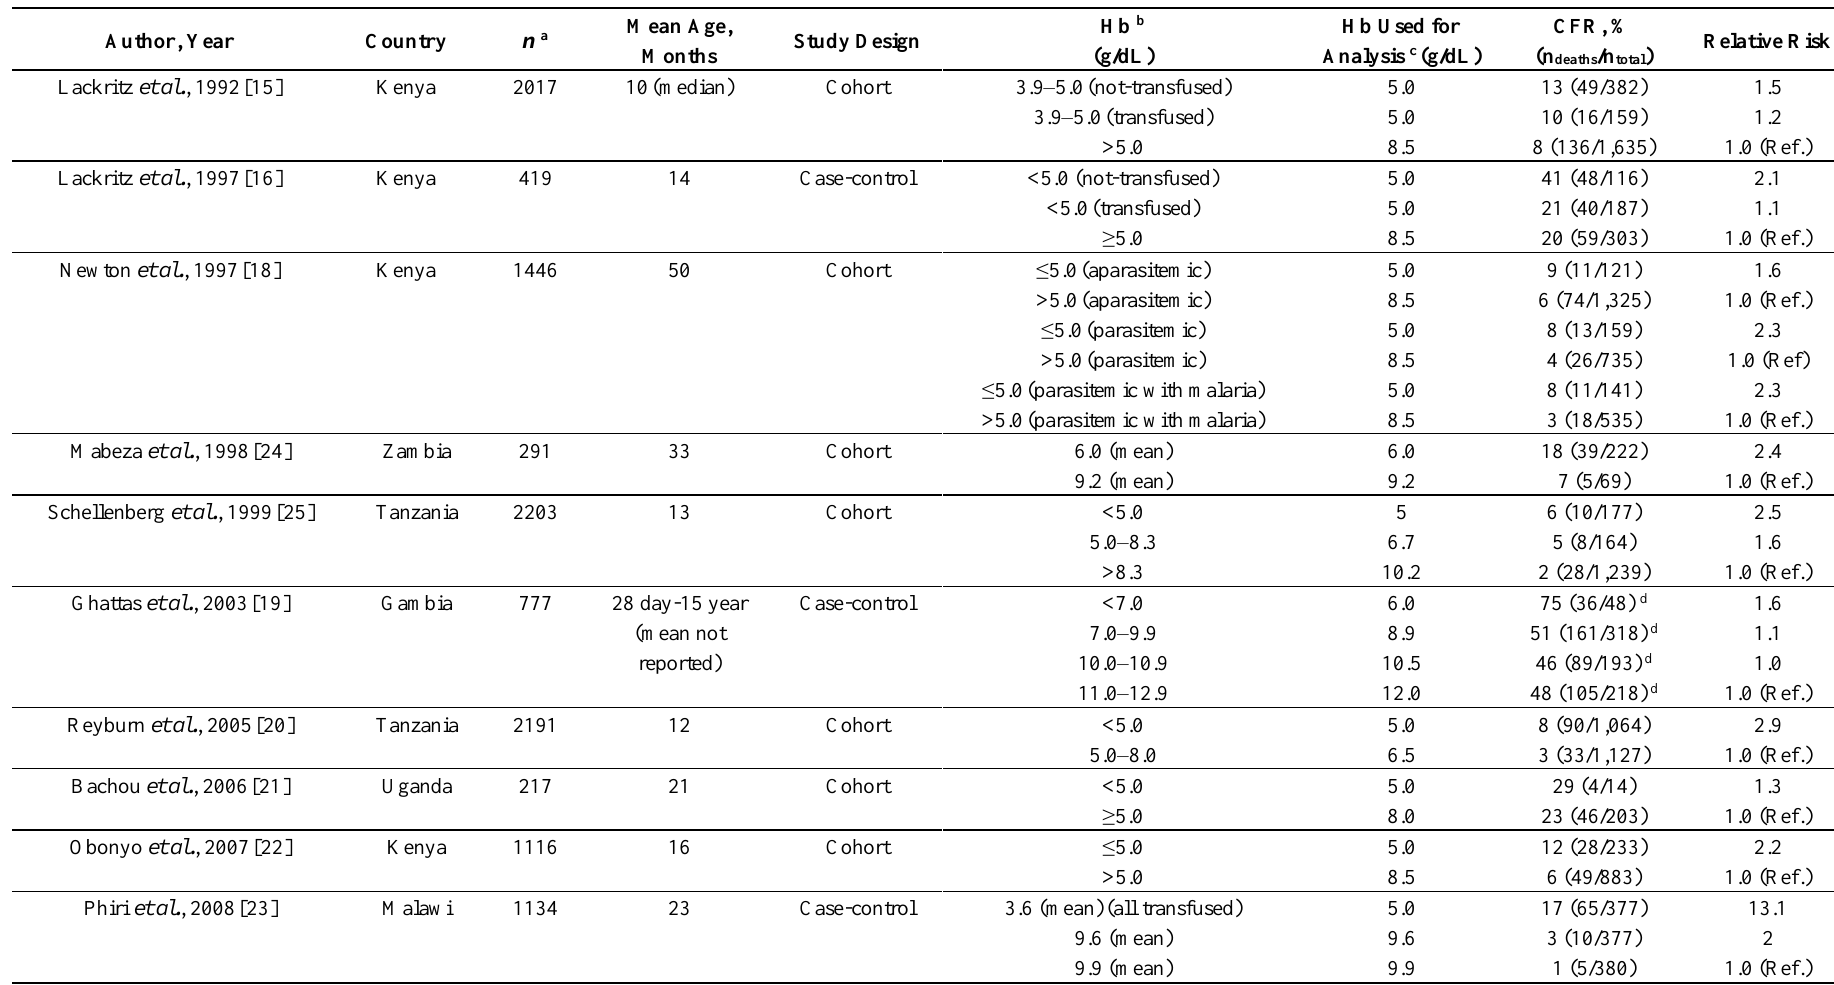
Table 1. Characteristics of the included